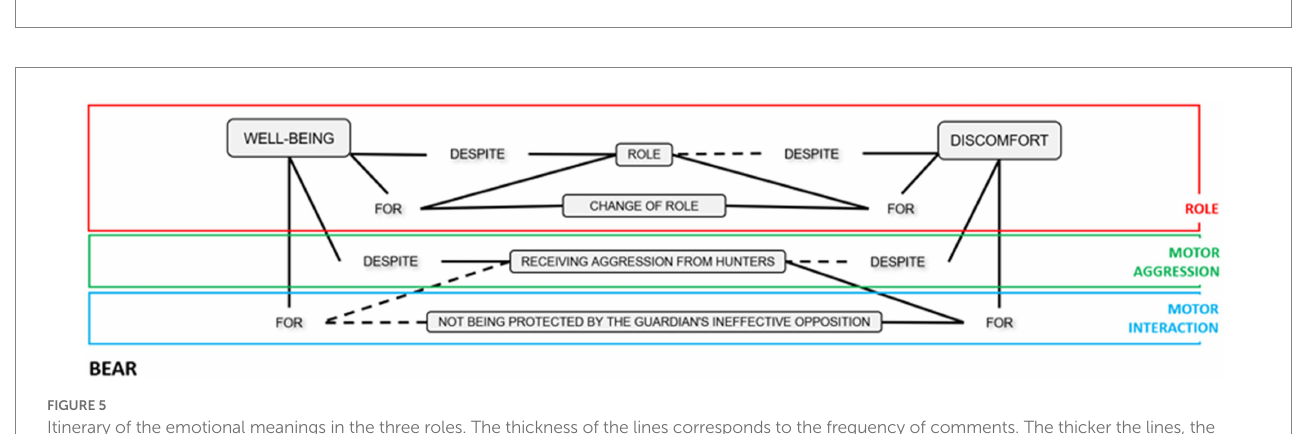
FIGURE 4 Units of emotional meaning in the Hunter role.